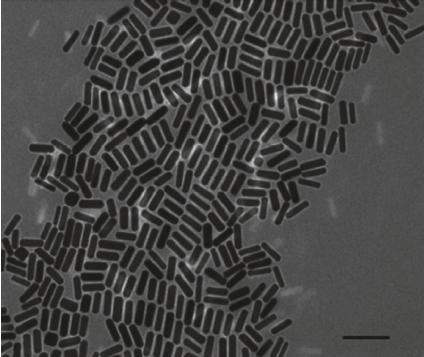
Figure 5: AuNRs prepared in the presence of a direction agent CTAB. Scale: 100 nm (TEM